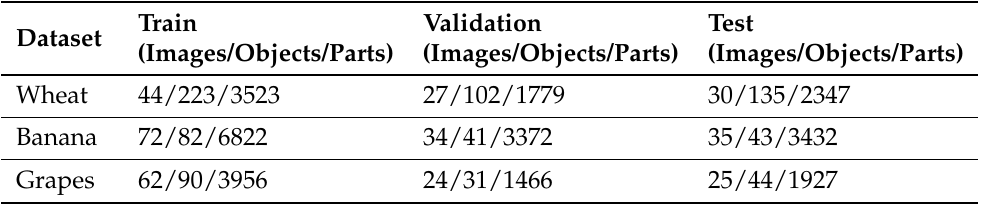
Table 1. Datasets